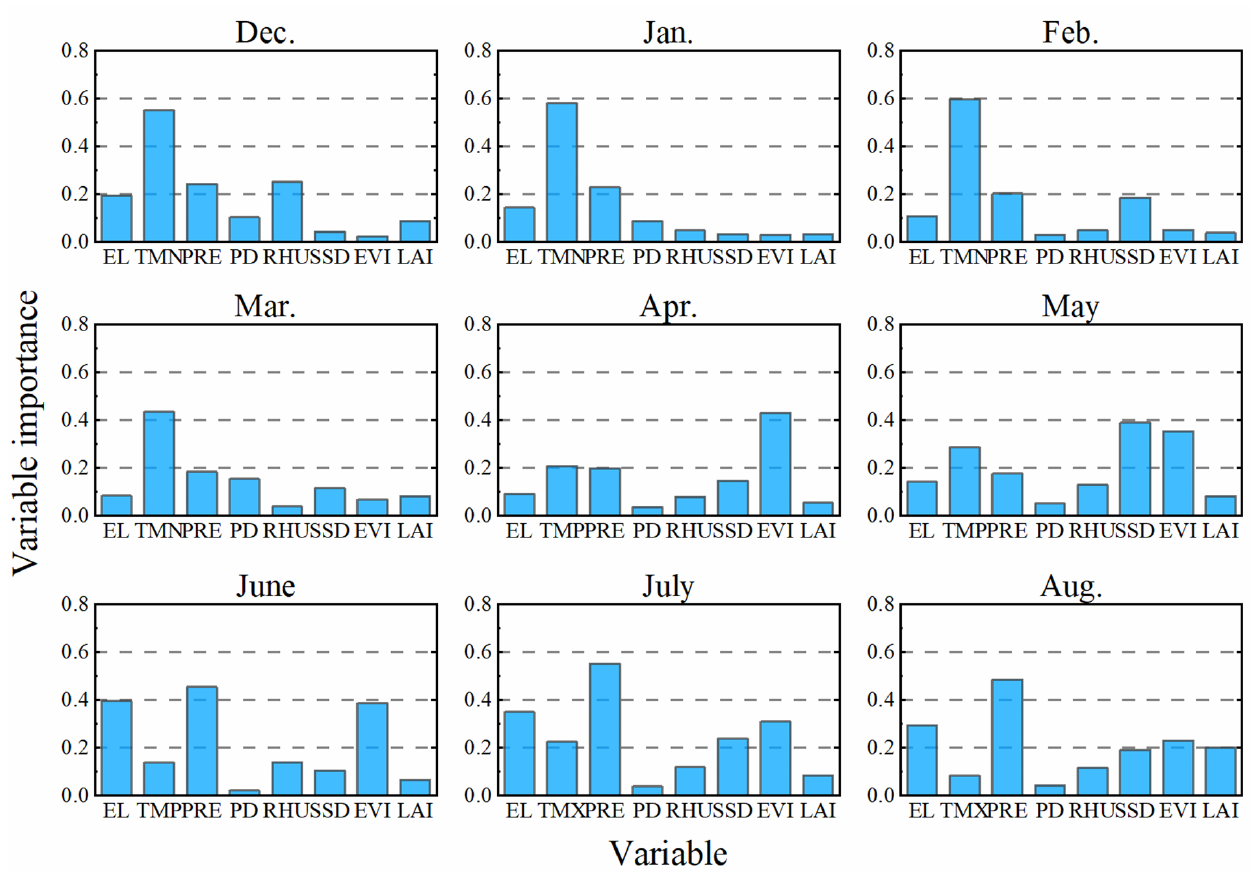
Figure 4. Variable importance of ensemble models from December to August.